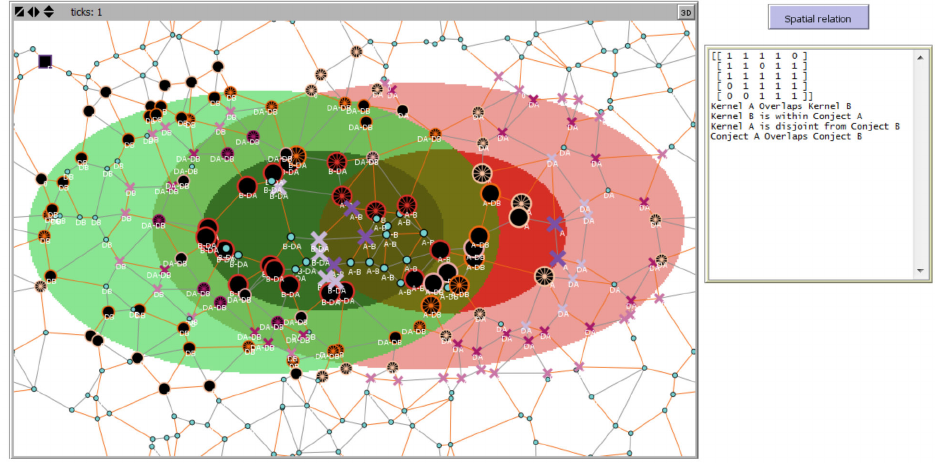
Figure 9. Poor modeling and qualitative specifications about a given scene monitored by a light dense SN of wide range sensors (case of scene